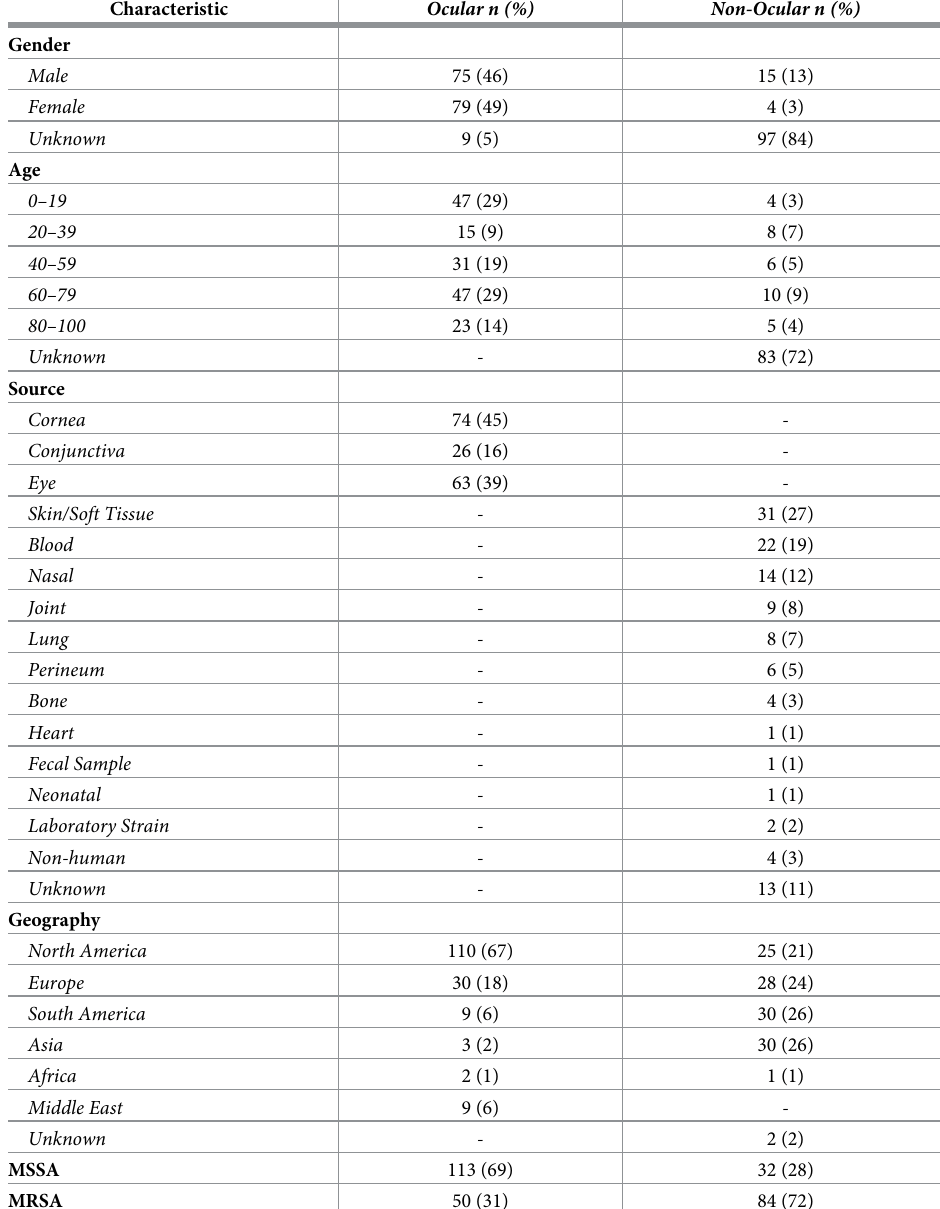
Table 1. Strain characteristics of a 163-member ocular and 116-member non-ocular S . aureus isolate collection. Characteristic Ocular n